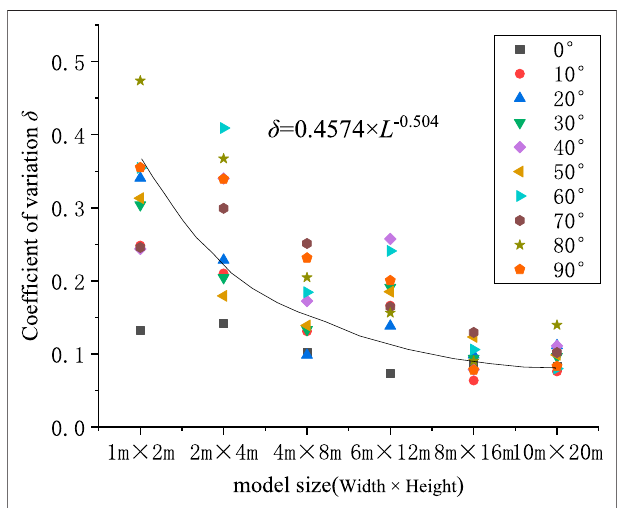
FIGURE 10 | Relationship between the sample δ and model size.